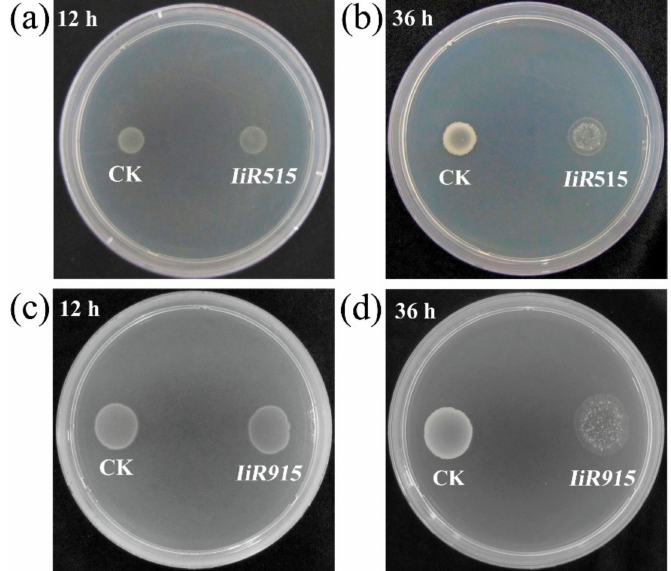
Figure 1. Damaging e ff ect of foreign proteins on host Bacillus subtilis cells. The engineered B. subtilis strains harboring IiR515 , IiR915 , and empty vector were separately spotted onto Luria-Bertani (LB) plates and incubated at 37 ◦ C. ( a ) IiR515 after 12 h of incubation and ( b ) after 36 h of incubation; ( c ) IiR915 after 12 h of incubation and ( d ) after 36 h of incubation. The empty vector-transformed B. subtilis strain (WB800-e) was used as a control. Spots on the right represent the test clones with damaging e ff ects and spots on the left represent the